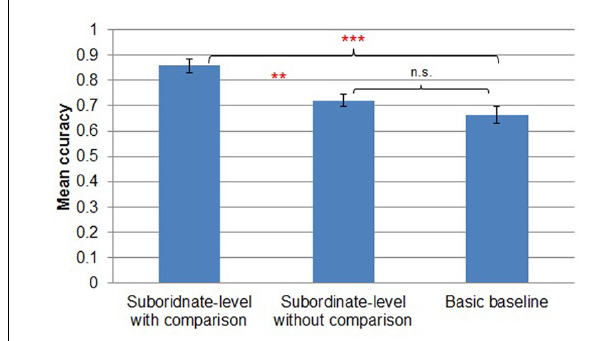
FIGURE 4 | Mean accuracy by transfer condition in Experiment 1. Error bars represent SEs. ** p < 0.01, *** p <